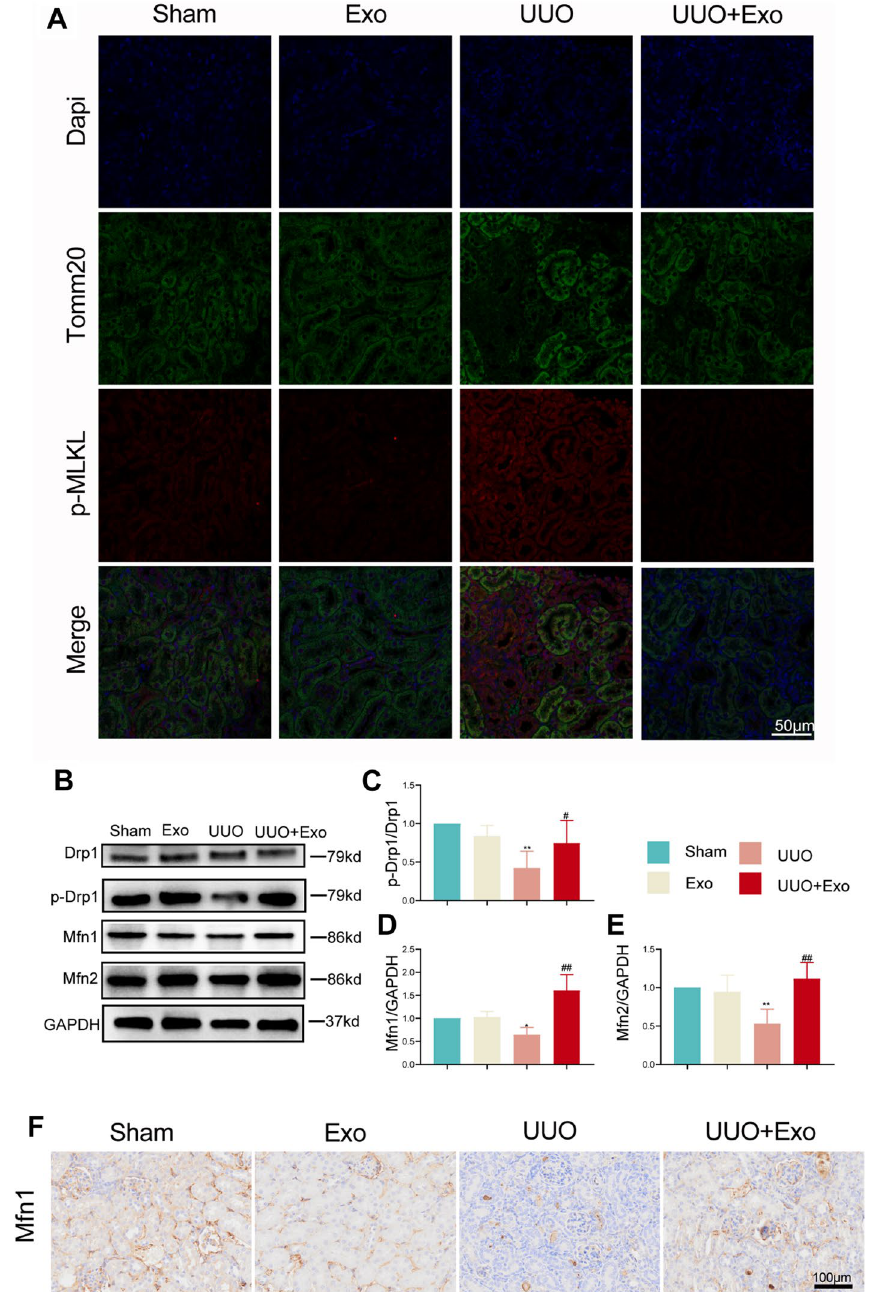
Fig. 4 Examination of mitochondrially related markers in four groups in vivo. A Immunofluorescence of Tomm20 and p-MLKL in the kidney sections in four groups. B Western blot of mitochondrial fusion-related markers (Drp1, p-Drp1, Mfn1, and Mfn2) in each group. C – E Relative expression of mitochondrial fusion-related markers detected by western blot. * p < 0.05, ** p < 0.01, compared with sham group; # p < 0.05, ## p < 0.01, compared with UUO group. F Immunohistochemistry of Mfn2 in each